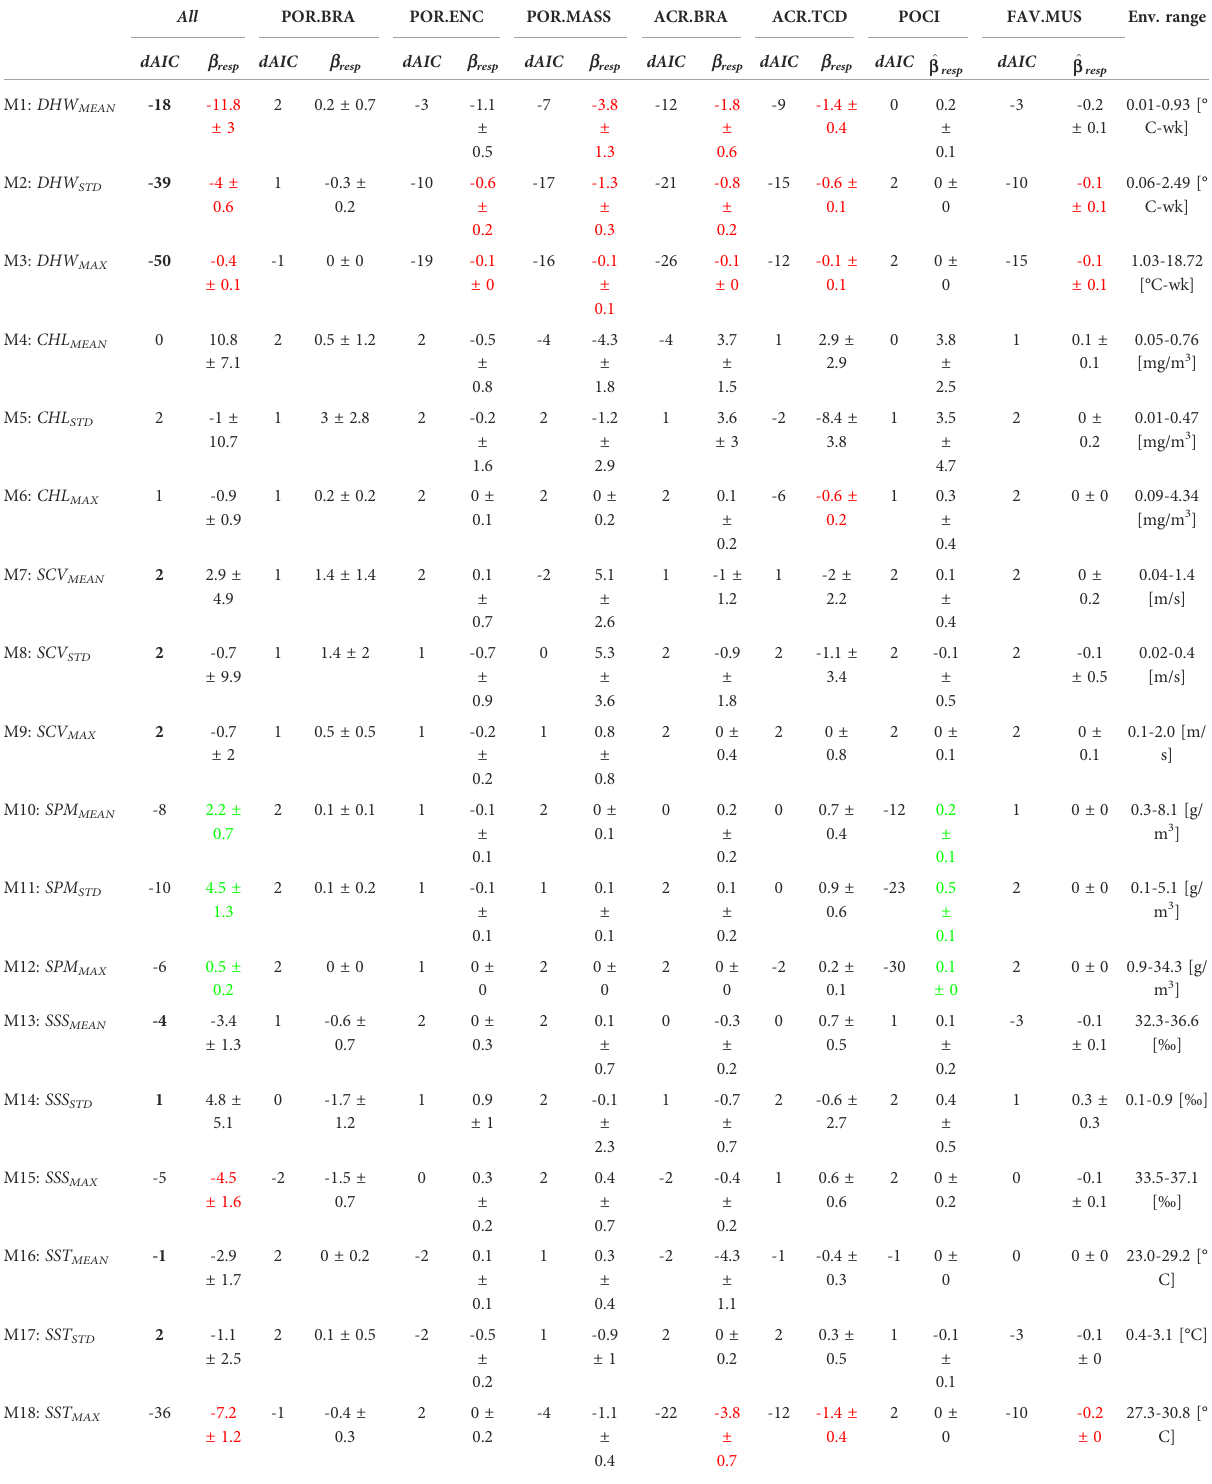
TABLE 2 Association models of coral cover with environmental trends. A) Univariate models of long-lasting environmental trends All POR.BRA POR.ENC POR.MASS